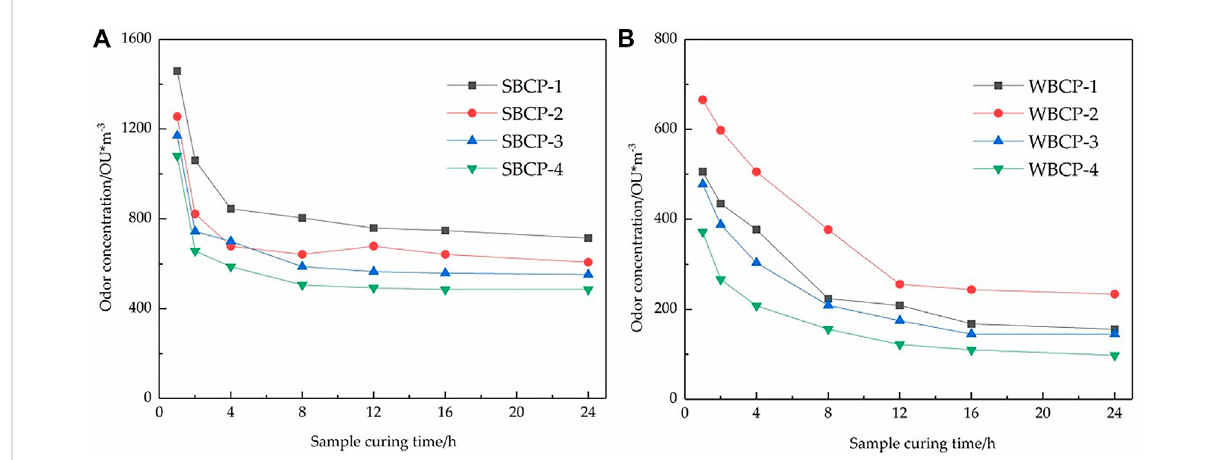
FIGURE 3 Effect of sample curing time on solvent-based (A) and water-based (B) coating product odor